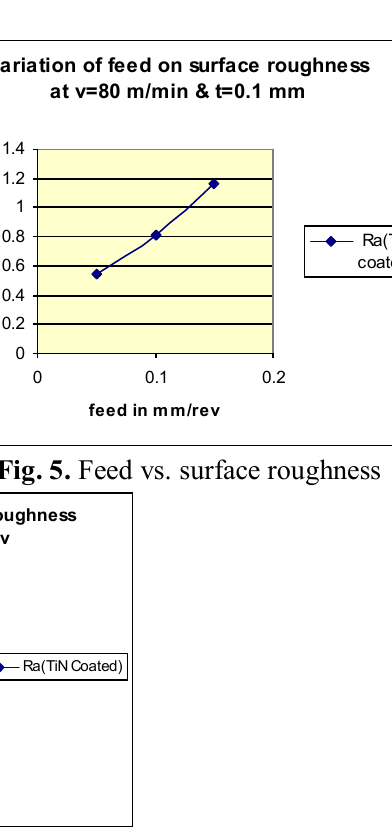
Fig. 6. Depth of cut vs. surface